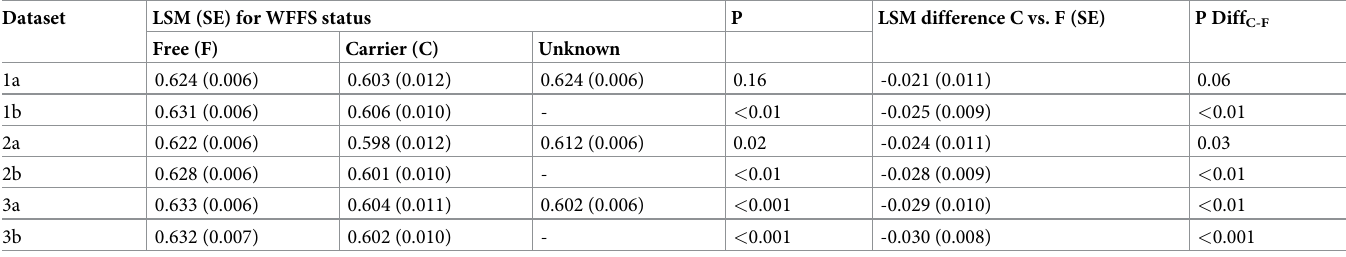
Table 2. Results of the multiple analyses of variance for the probability of a living foal and the WFFS status of the sire, with least square mean estimates (LSM) and differences with respective standard errors (SE) and error probabilities (P).